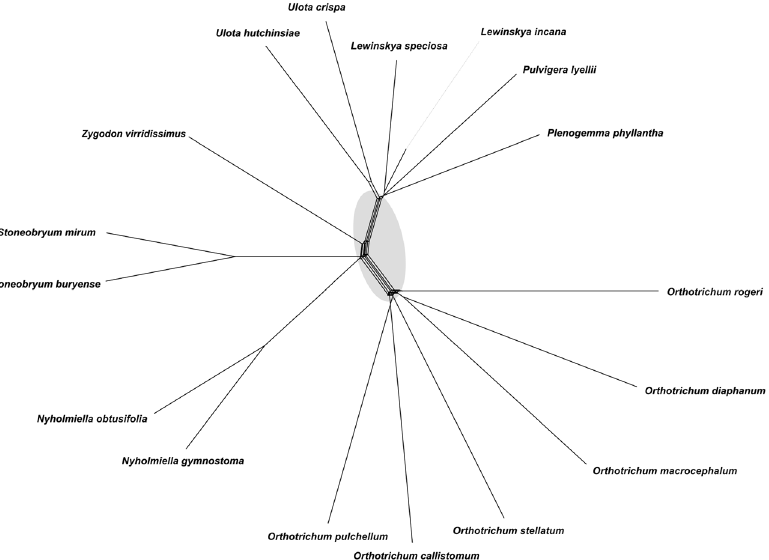
Figure 2. A supernetwork of 64 of 92 Orthotrichaceae mitochondrial single-locus trees constructed using SplitsTree. Parallelograms indicate incongruence among single-locus trees, and gray-shaded areas encompass the competing splits among major Orthotrichaceae